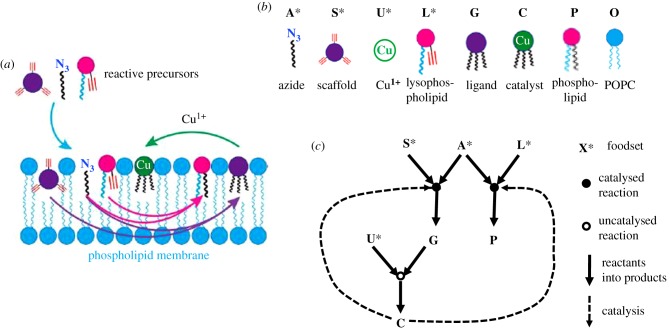
(a) Summary diagram of a study of self-reproducing catalyst that drives recurred phospholipid synthesis and membrane growth [193]. The experiment starts with vesicles of a regular phospholipid (palmitoyl-oleoyl-phosphatidyl choline, POPC), shown in light blue. Figure reproduced from [193]. (b) As also shown in a, other components added to the reaction vessel are: 1-azidododecane (azide), tripropargylamine (alkyne scaffold), Cu+1 cuprous ions, alkyne modified lysolipid and Tris-(lauryl triazole)amine (TLTA, ligand). Then, in a spontaneous uncatalysed reaction, the TLTA ligand binds Cu+1 ions to form some copper-chelated oligotriazole (catalyst). This membrane-embedded lipid catalyst is capable of enhancing the rate of two reactions within the bilayer. The first, catalytically generates phospholipid from lysolipid and azide, and the second, catalytically generates more lipid catalyst. This self-reproducing catalyst drives triazole phospholipid synthesis and membrane growth. The carrier lipid palmitoyl-oleoyl-phosphocholine (POPC) does not take part in the reaction network. (c) The above chemical reactions are presented in a mutually catalytic network diagram format [216]. Four food compounds (labelled by asterisk) participate in two catalysed and one uncatalysed reaction. The scheme is formally not reflexively autocatalytic (RA) [216] because one reaction is uncatalysed. Yet, because that reaction occurs spontaneously with good efficacy, the system appears to show catalytic closure. Further, as described in the text, after many serial transfers, the carrier lipid POPC gets diluted out and this network becomes capable of showing catalysed homeostatic growth (preservation of the ratios of all components).